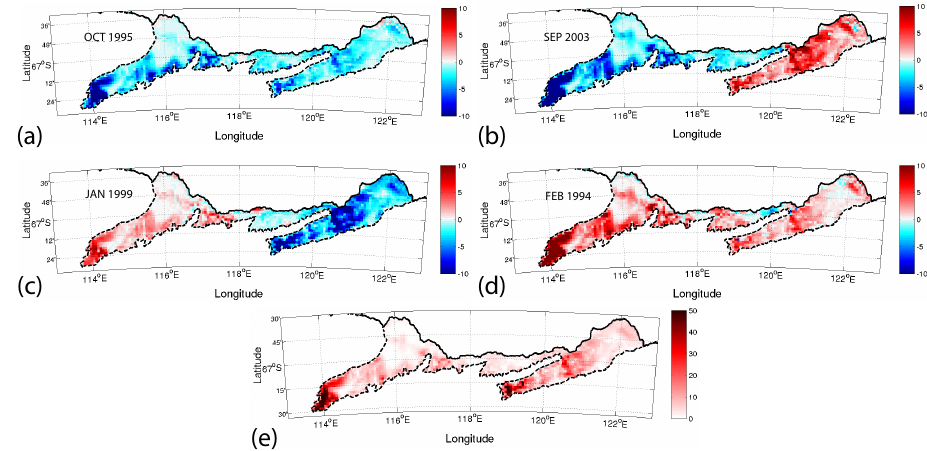
Fig. 4. The anomaly from the mean melt rate over the period 1992–2007 is shown at (a) October 1995 (b) September 2003 (c) January 1999 (d) February 1994. (e) The mean melt rate over the period 1992–2007. Larger positive numbers indicate higher